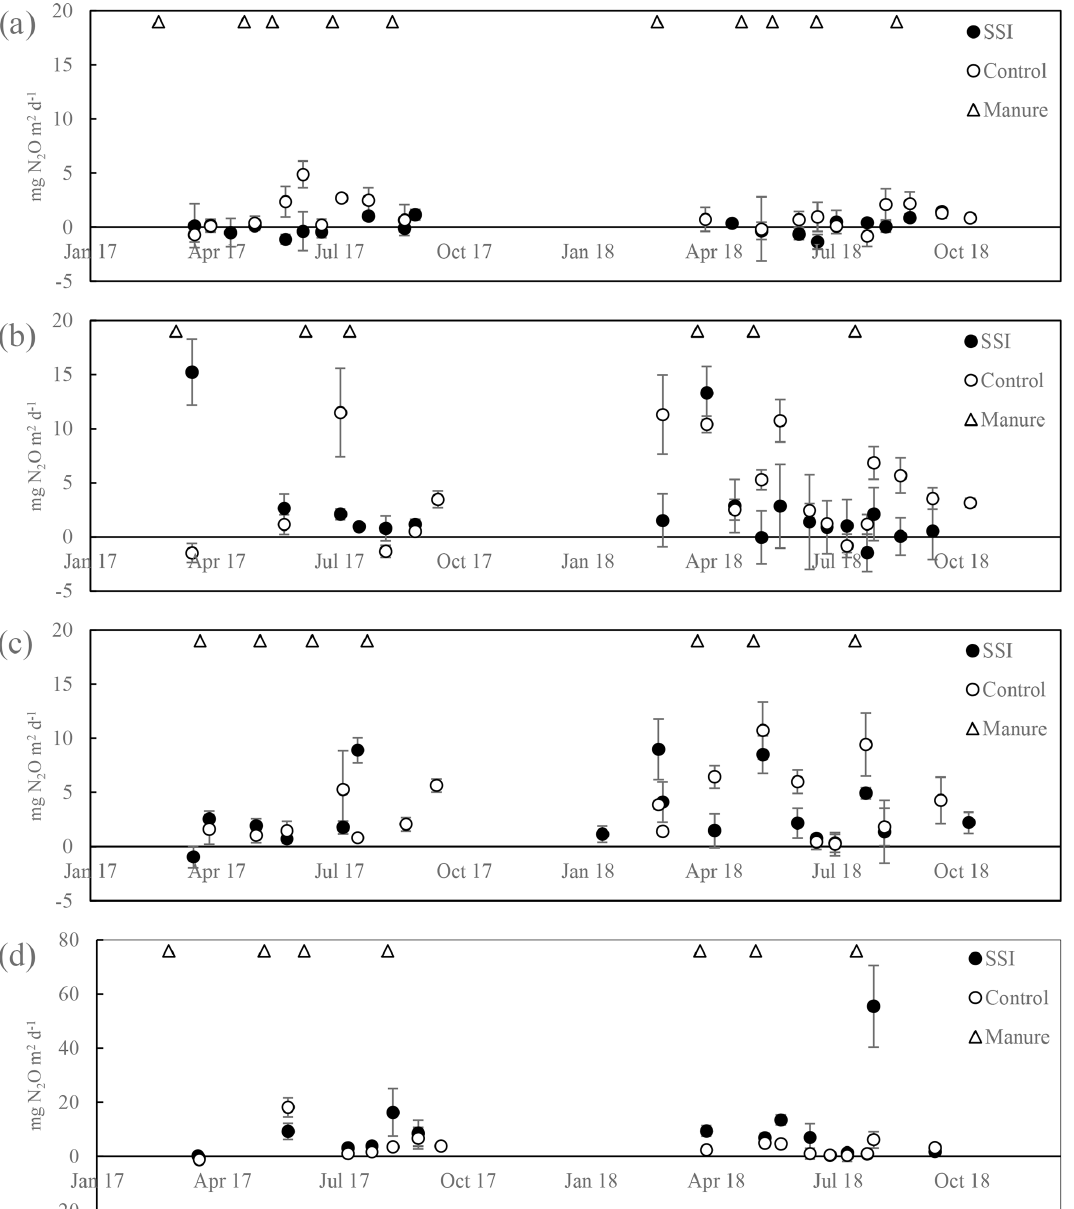
Figure D1. N 2 O exchange throughout 2017 and 2018 in mgN 2 Om − 2 d − 1